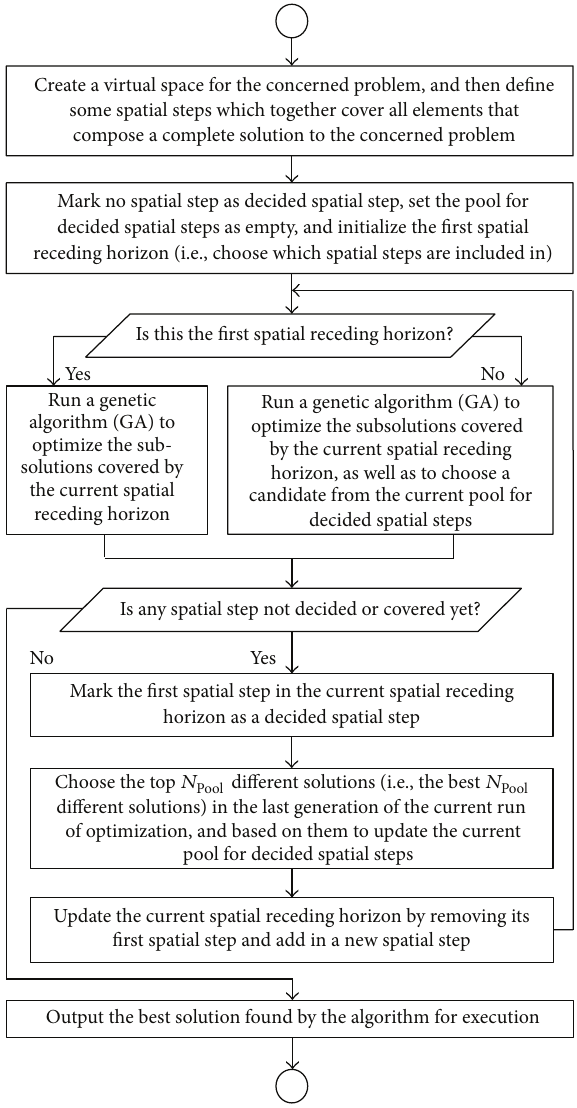
Figure 5: Flowchart of SRHC with GA as online